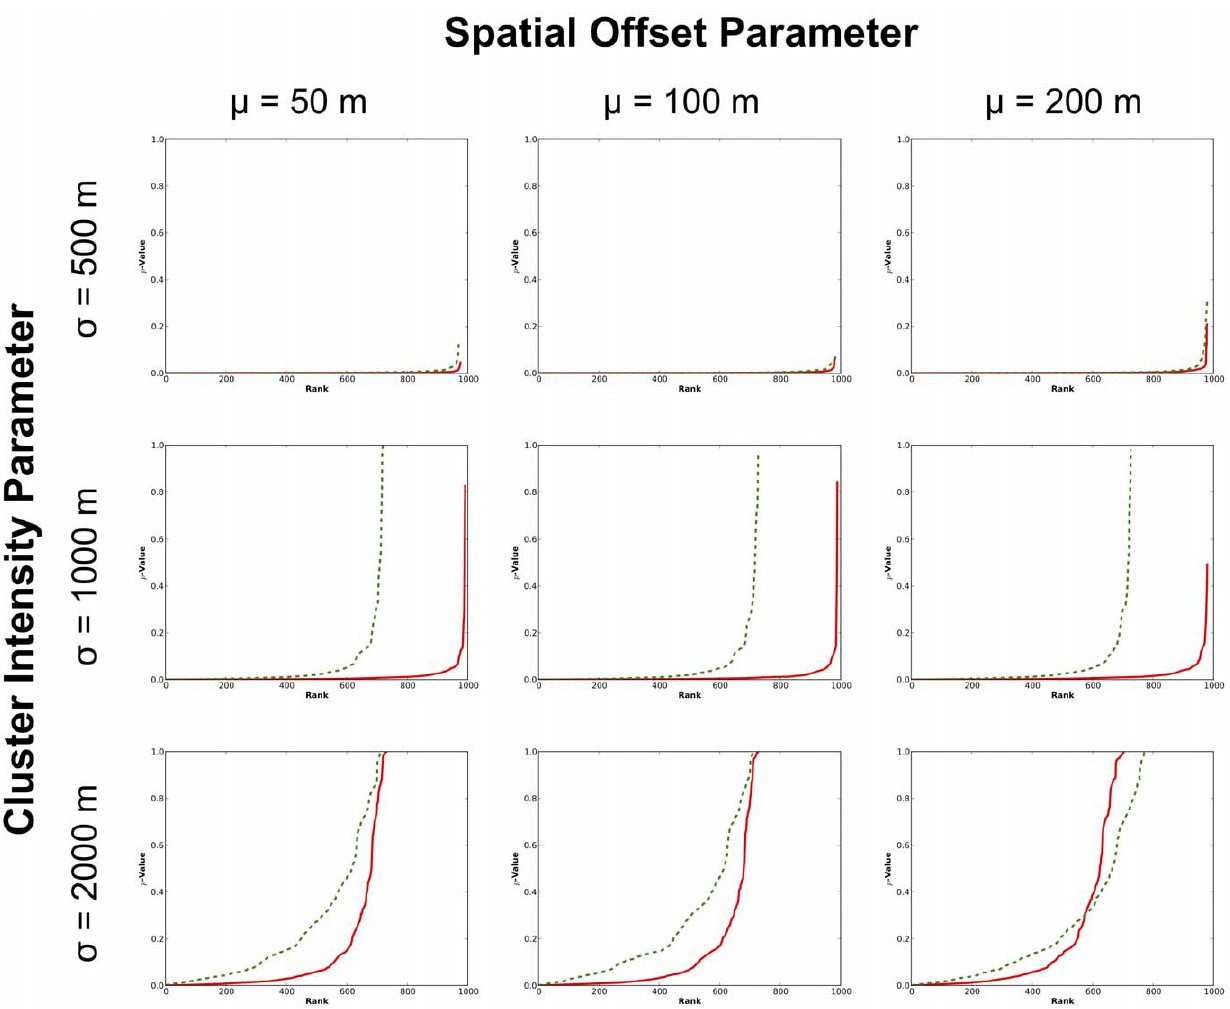
Figure 13. Pseudo p -values determined by the STPSS for likely clusters identified in the vicinity of the original cluster 1 ( red solid line ) in each perturbed version of the original datasets.